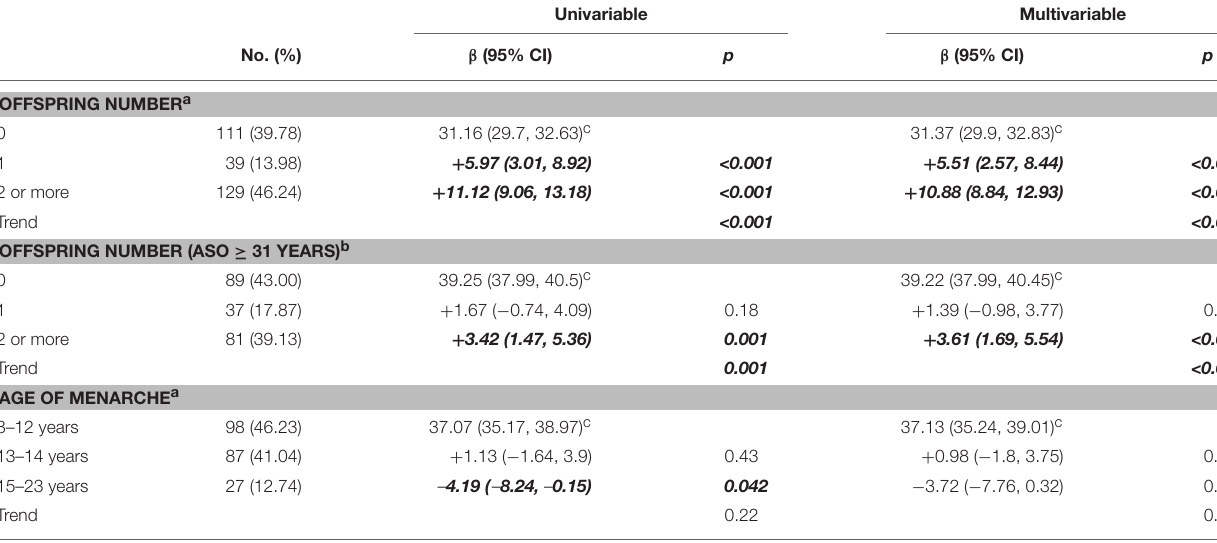
TABLE 4 | Associations between offspring numbers/age at menarche and age of symptom onset.